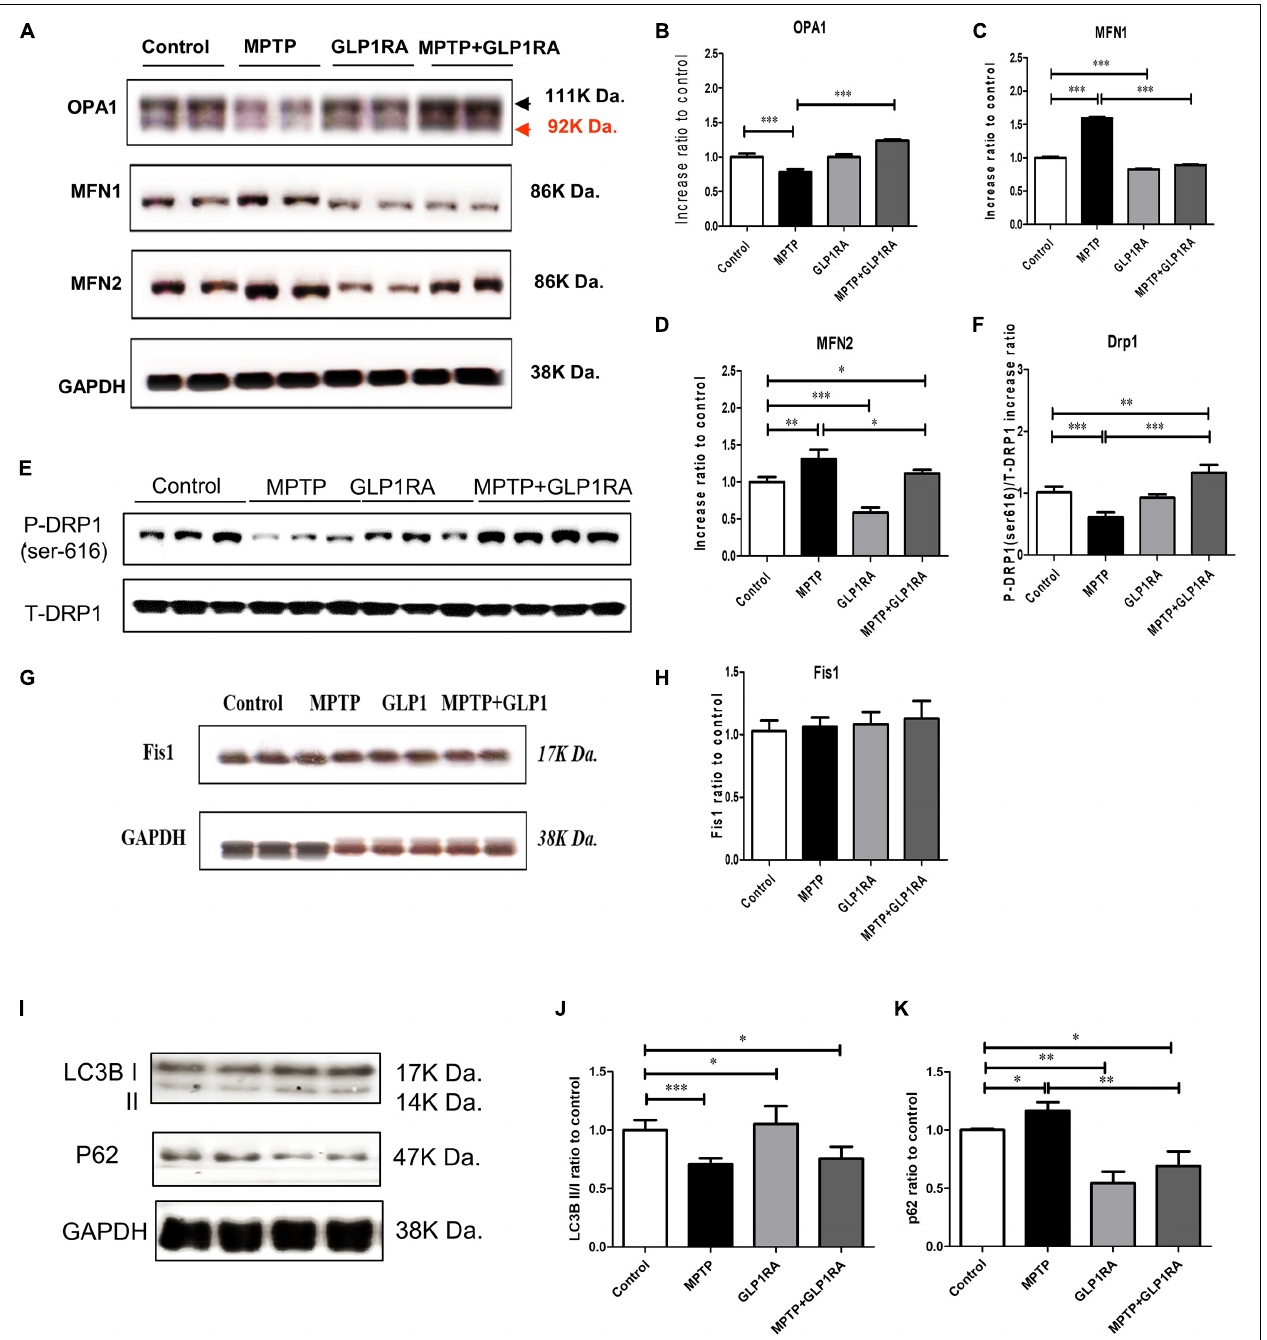
FIGURE 5 | The GLP-1RA (liraglutide) partially normalizes mitochondria dynamic imbalance and restores MPTP-induced impaired autophagy flux. Mice were treated according to the four groups: control/MPTP/GLP-1RA/MPTP + GLP-1RA, and sacrificed on the 3rd day. Substantia nigra tissues were obtained. Representative Western blots and bar diagrams of the mitochondrial fusion regulatory proteins (A,B) OPA1, (A,C) MFN1, (A,D) MFN2, and fission regulatory proteins (E,F) pDRP1 and (G,H) Fis-1 of the four independent experiments ( n = 4) are presented. The dysregulation of fusion and fission regulatory proteins levels due to MPTP exposure were rebalanced with GLP-1RA treatment. Representative Western blots and bar diagrams of (I,J) autophagy induction marker, LC3B, and (I,K) autophagy adapter, p62, of the three independent experiments ( n = 3) are presented. The LC3B-II/LC3B-I ratio was reduced and p62 accumulated in the MPTP group while the GLP-1RA was able to decrease this p62 accumulation significantly suggesting that the GLP-1RA enhanced autophagy flux. Protein expressions were normalized to GADPH as an internal standard and quantified using Image J. The values represent mean ± SD (one-way ANOVA, * P < 0.05, ** p < 0.01, *** P < 0.001). GLP-1RA, glucagon-like peptide-1 receptor agonist; OPA1, optic atrophy 1; MFN1 and 2, mitofusin 1 and 2; Drp1, dynamin-related protein 1; Fis1, mitochondrial fission protein 1; p62, p62/SQSTM1; LC3B, microtubule-associated proteins 1A/1B light chain 3B.